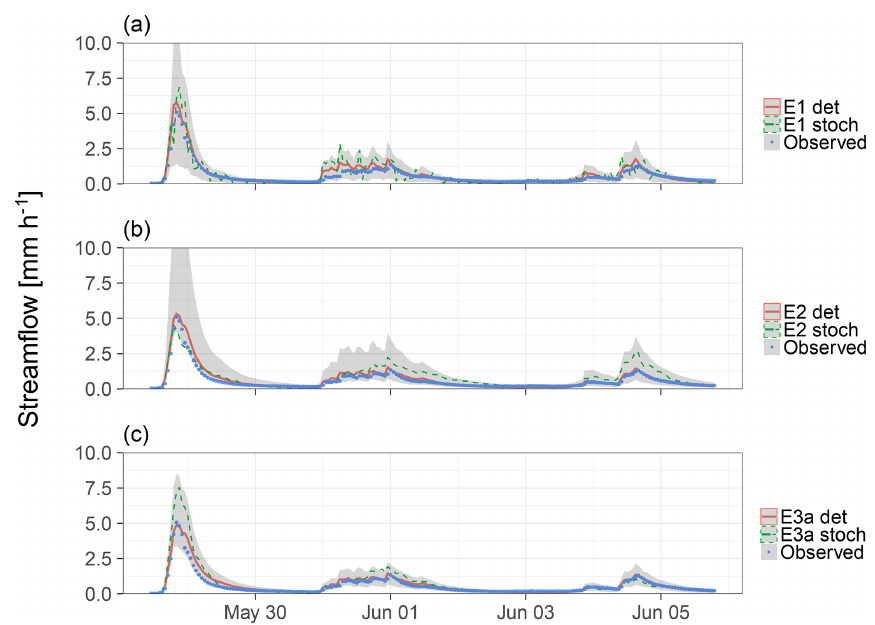
Figure 5. Streamflow predictions with hourly resolution in the Maimai catchment in a part of the validation period (1993) obtained with error models E1 (a), E2 (b) and E3a (c). Deterministic predictions with the parameter values at the maximum posterior density are shown together with the 90%-confidence bands and one single stochastic streamflow realisation for each of the error